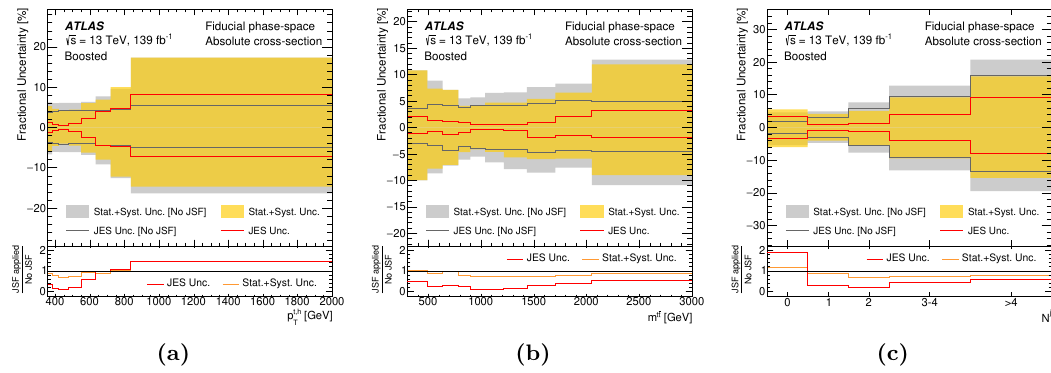
Figure 7. Effect of the JSF correction on the total uncertainty of the cross-section measurements as a function of (a) p of the hadronically decaying top quark ( p t,h ), (b) invariant mass of the T T ¯ t ) and (c) the number of additional jets in the event ( t ¯ t system ( m t N j ). The yellow (grey) bands represent the total uncertainty with (without) the JSF correction applied. The red (grey) line in the upper pad shows the JES uncertainty with (without) the JSF method. The bottom pad shows the ratios of the absolute size of the uncertainty with and without the JSF correction applied, in red for the JES uncertainty and in yellow for the total uncertainty.